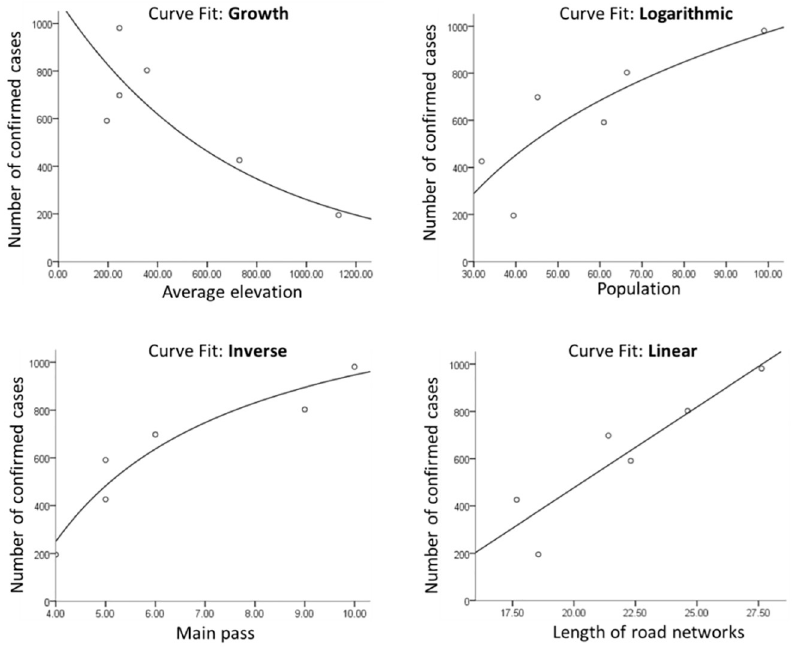
Fig 6. The function relationship between the factors and the confirmed cases in the second week. (figure was drawn by author).